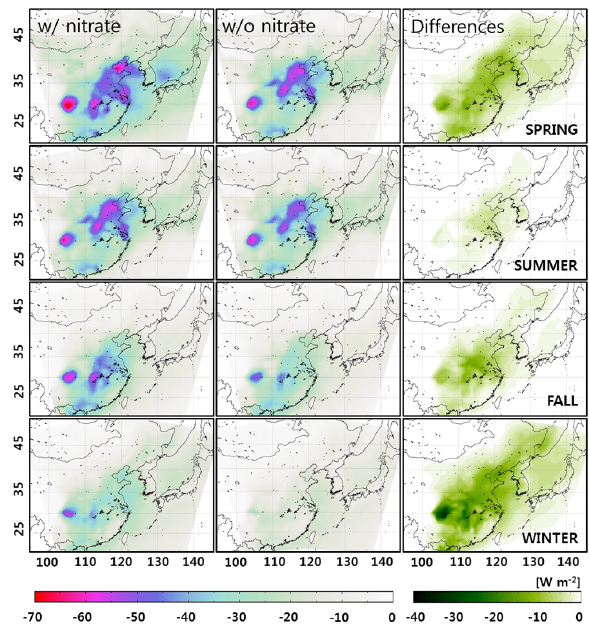
Fig. 13. Direct radiative forcing (DRF) by aerosols at the top of the atmosphere under clear-sky conditions estimated by the SBDART model simulations for the cases with and without NH 4 NO 3 (the first and the second columns) over East Asia for the four seasons in 2006. Since the DRF values were calculated with total aerosol composition, they showed large negative values (the first column) in spring and summer. These are due to seasonal formation and/or gen- eration of different particulate species such as ammonium sulfate ((NH 4 ) 2 SO 4 ) and mineral dust. For example, the formation rates of (NH 4 ) 2 SO 4 are maximized in summer and minimized in win- ter. The third column presents the differences between the first and the second columns. These differences indicate the contributions of NH 4 NO 3 to DRF by aerosols in East Asia.